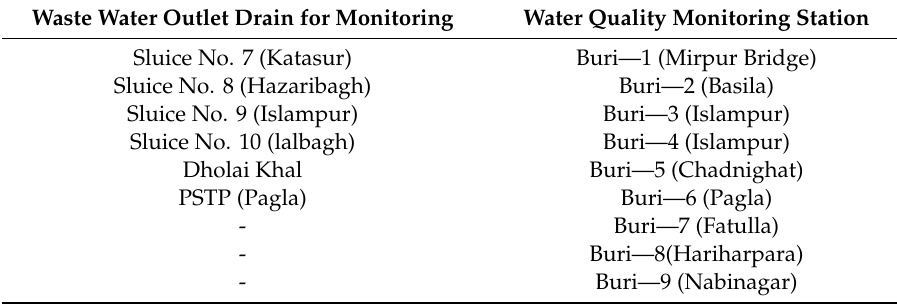
Table 3. Sampling sites of Institute of Water Modelling for the Buriganga River.